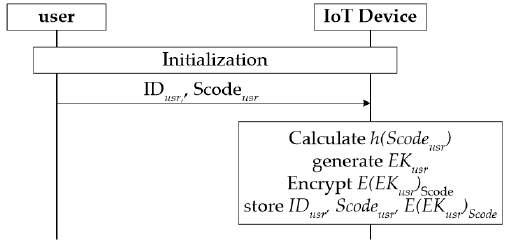
Figure 4. Initialization of user and IoT